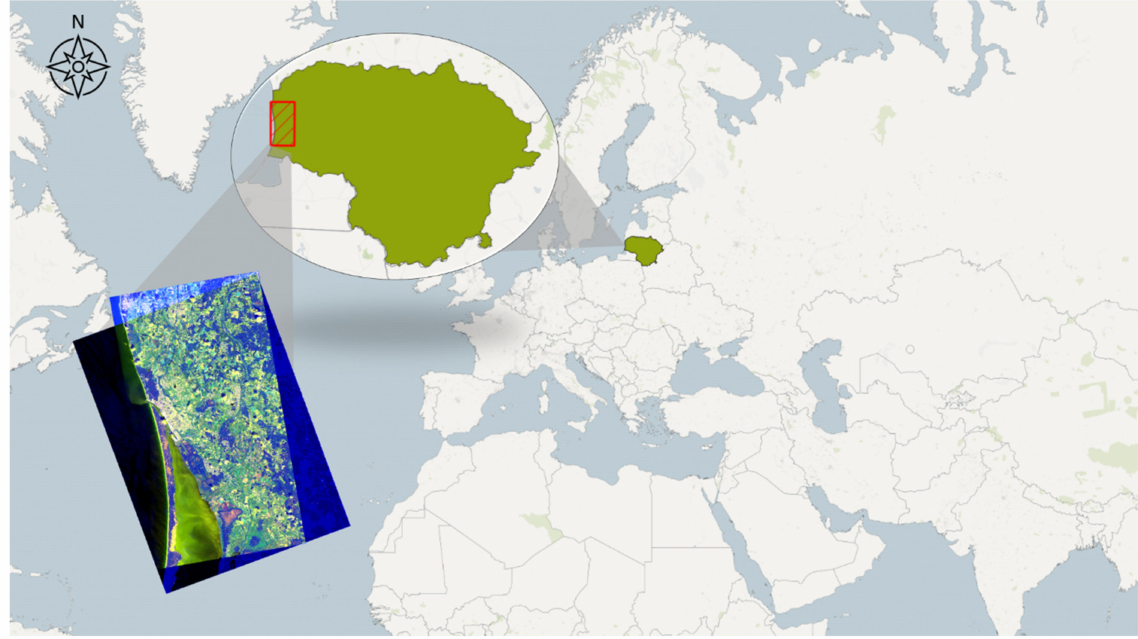
Figure 1. Location map of the study